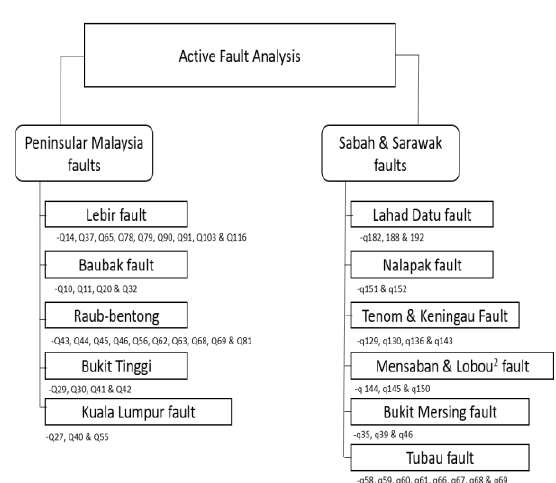
Figure 6. Phase 3: Active fault analysis with its Quasi- Network points prior to the major